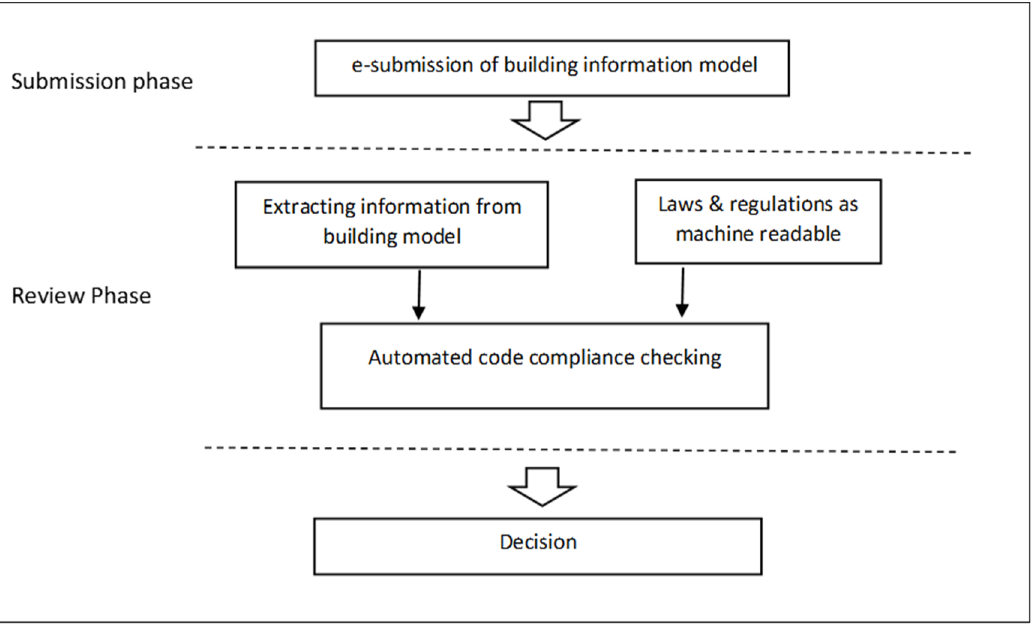
Figure 1. General conception of the BIM-based building permit process (adapted from Shahi et al.